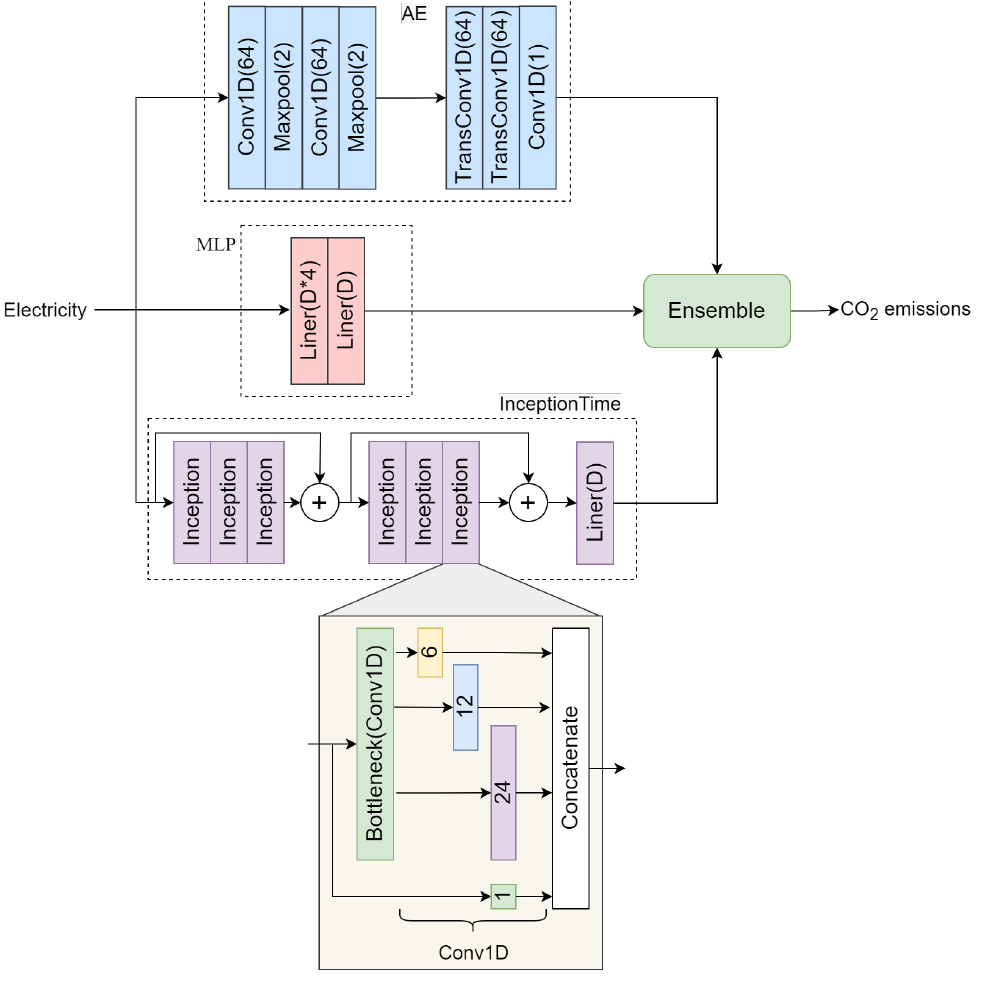
Figure 11. The architecture of Emission Estimation